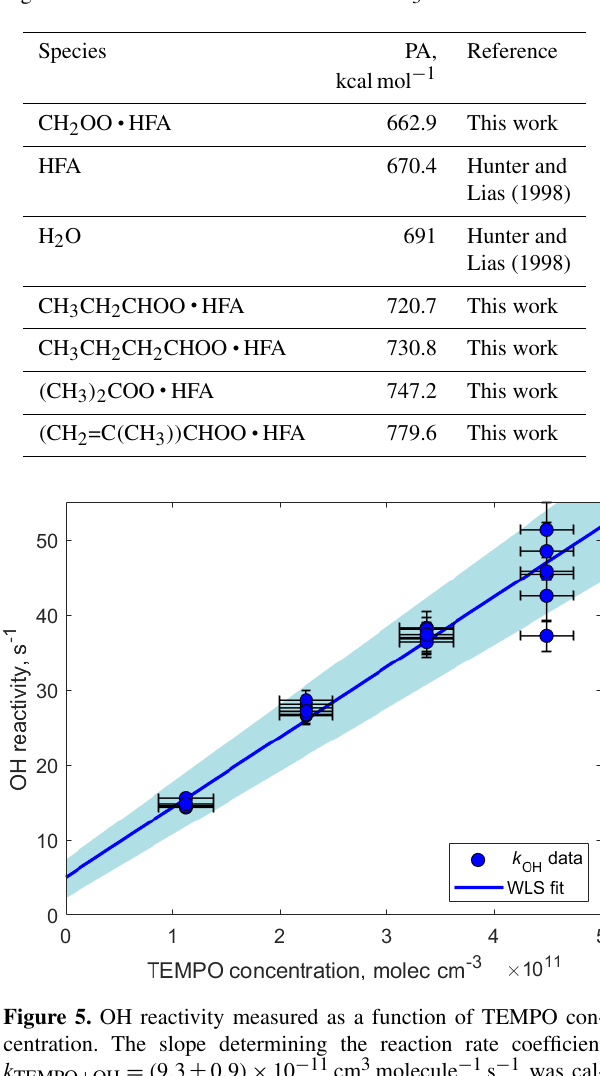
Table 1. Proton affinities (PAs) of HFA, water, and secondary ozonides produced in reactions of SCIs with HFA. Species with PAs higher than that of water can be detected in H 3 O + CIMS.